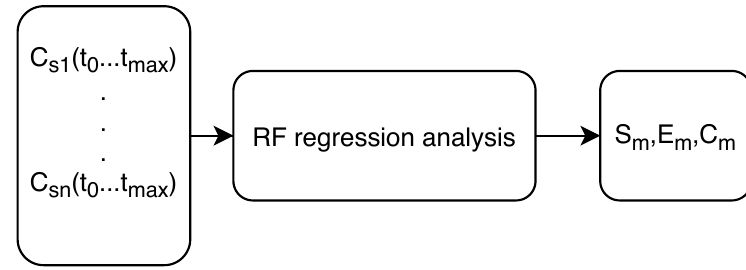
Figure 5. Flowchart of the RF regression analysis.